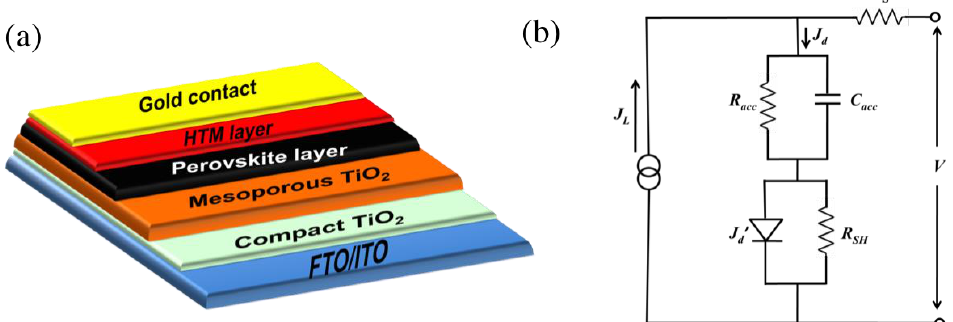
Figure 1. Schematic representation of ( a ) a perovskite solar cell (PSC) and ( b ) a single diode model of a PSC.